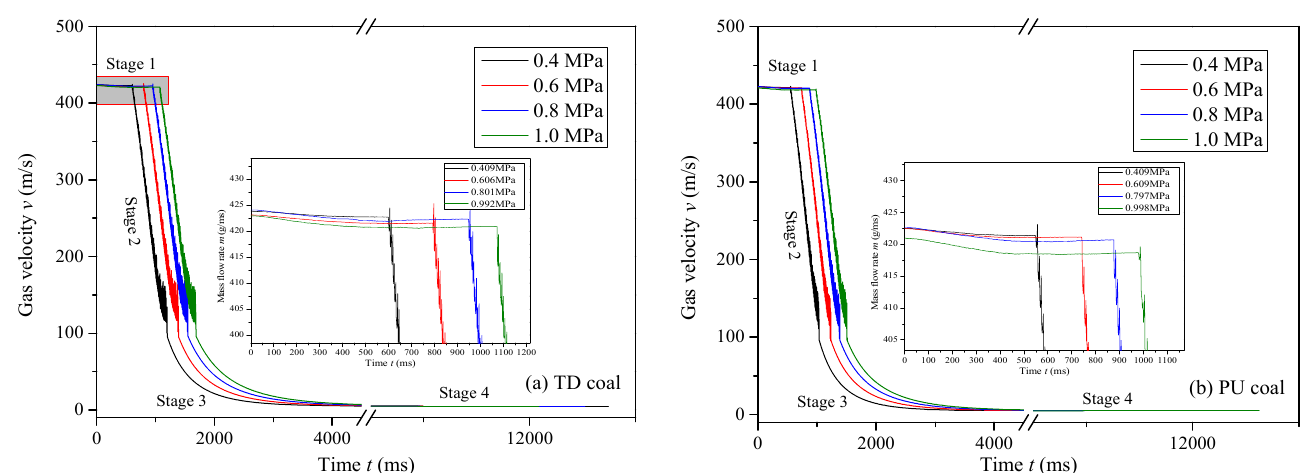
Figure 8. Change curve of gas velocity vs. time under different gas pressures during gas initial desorption of coal particles.